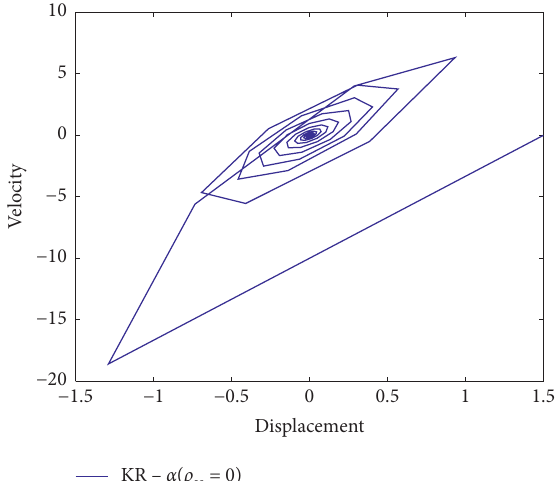
Figure 30: Phase portrait of the hardening spring calculated using the KR- α method ( ρ